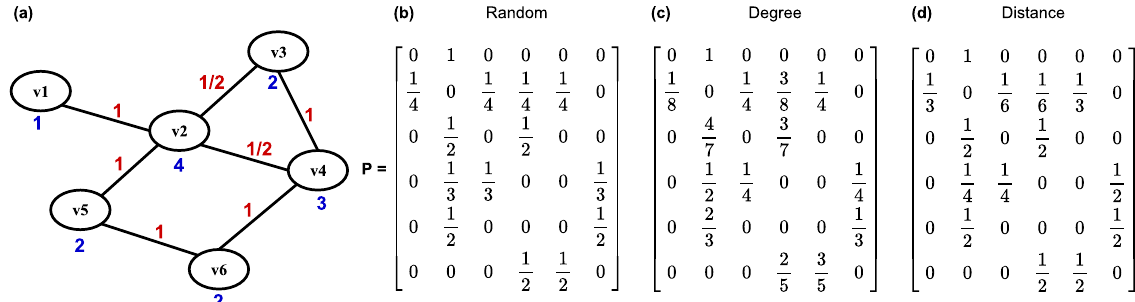
Figure 5. ( a ) Graph topology with node degrees deg ( v i ) and edge distances t ij respectively annotated in blue and red. Probability matrix P for the corresponding ( b ) random, ( c ) degree and ( d ) distance gossip